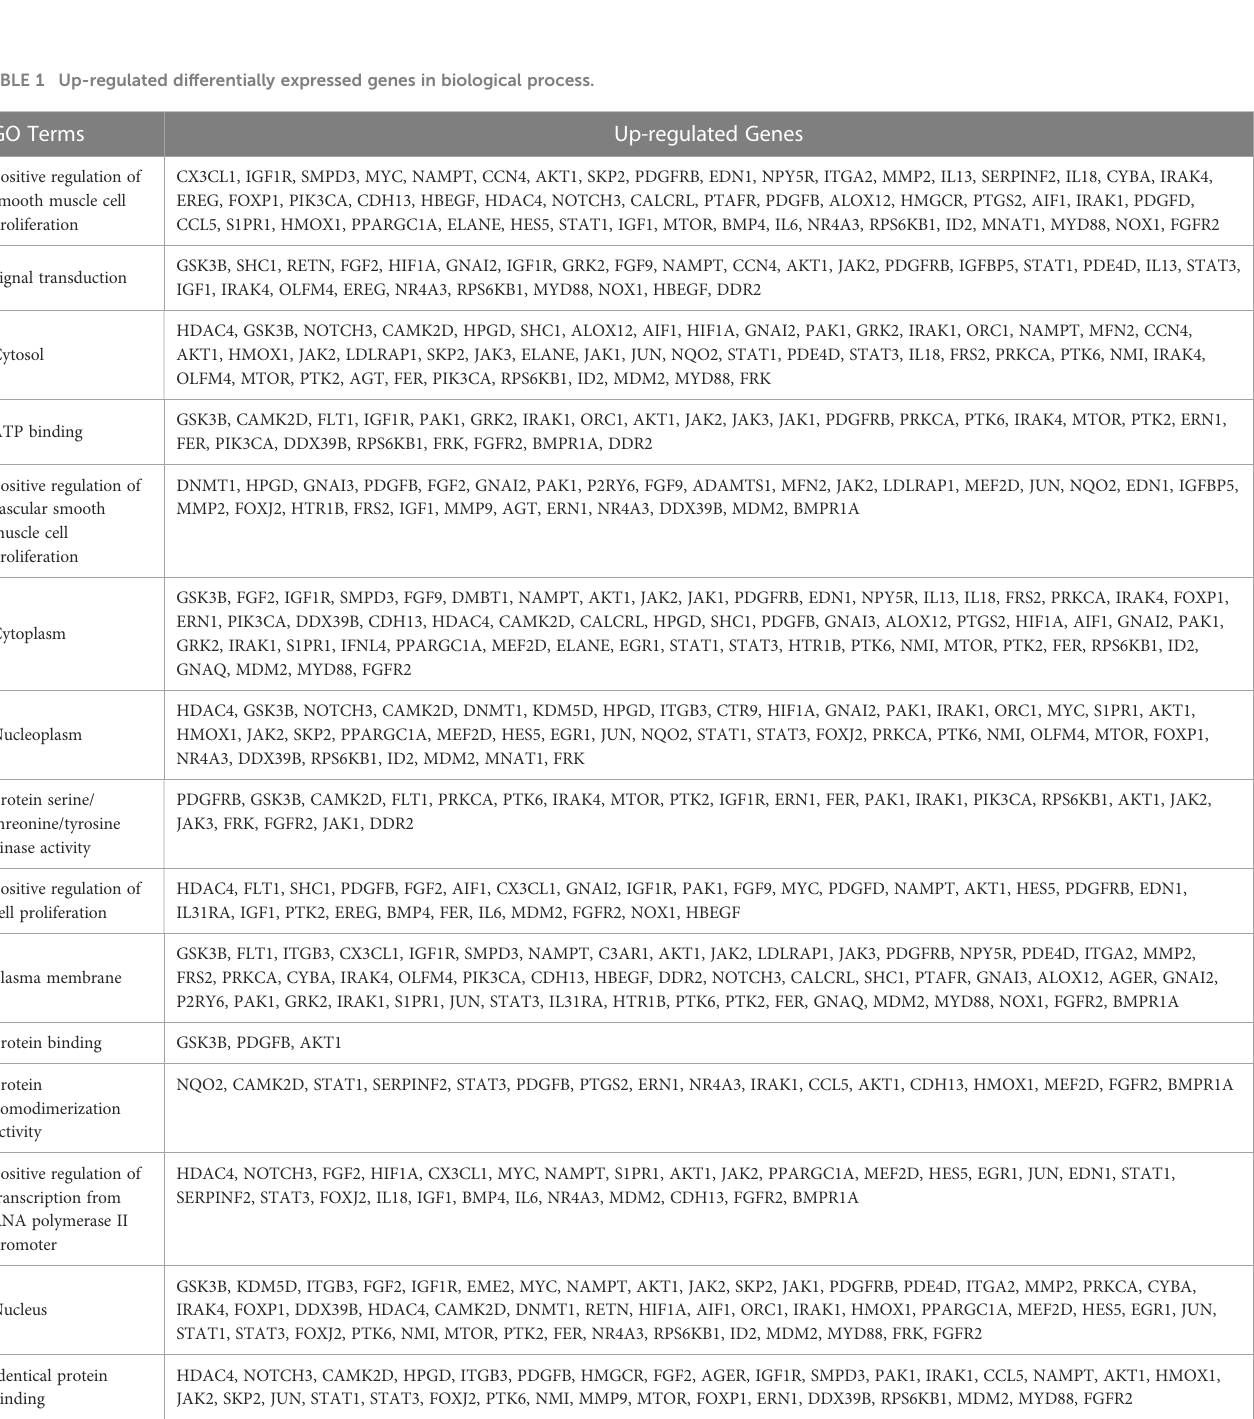
TABLE 1 Up-regulated differentially expressed genes in biological